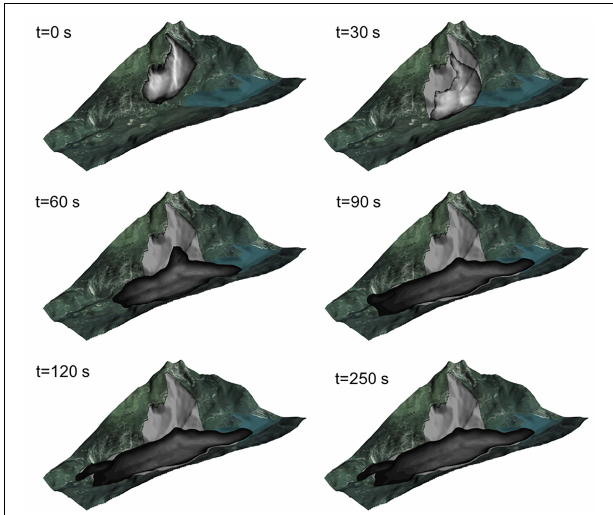
FIGURE 8 | Time series of runout. The first image at t = 0 s is showing the initial state. The first 30 s are in flexible mode that means the whole mass moves as intact body with a frictional rheology. After t = 30 s the model disintegrates and behaves as a Voellmy liquid. At t = 60 s the model runs up on Monte Gazza (opposite side of valley). At t = 90 s the model spreads more to N and S . At this time the landslide material already flowed back down from Monte Gazza. The gray colored area shows its maximum extent. At t = 120 s the maximum extent of the model is reached and only small changes in thickness and internal movement still happen. Photo by AGEA ©